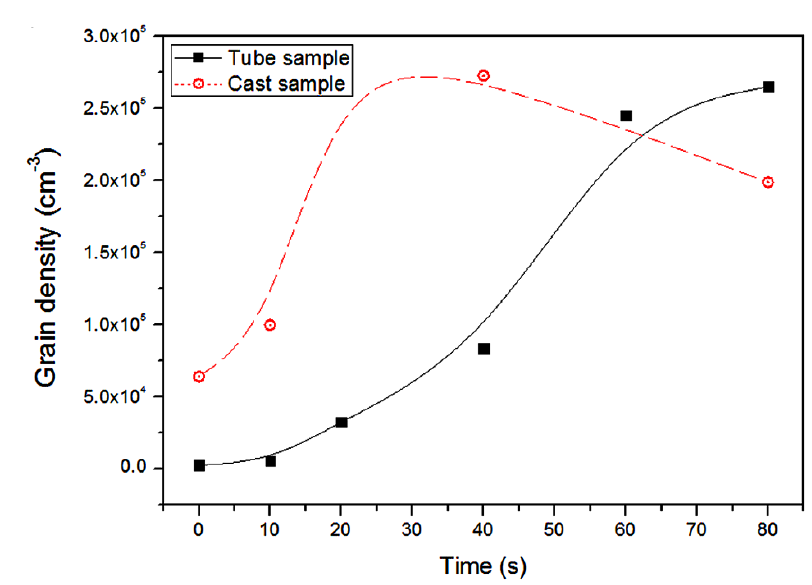
Figure 17. Comparison of grain density measurement of castings (Figure 11a in [76]) and tube samples (Figure 10b in [76]).